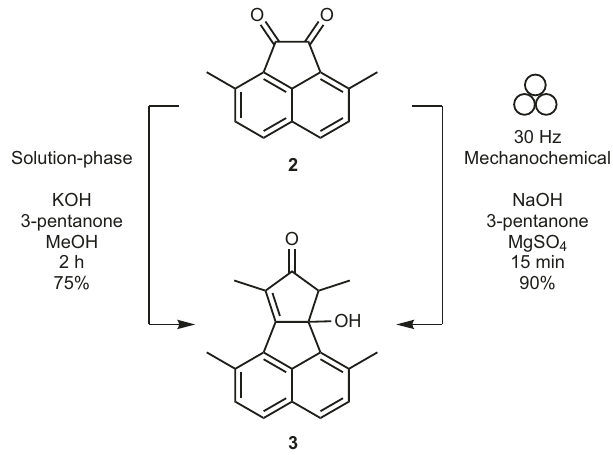
Fig. 2 Synthesis of 3. The solution-phase reaction was reproduced using the procedure provided in Butter fi eld et al. 55